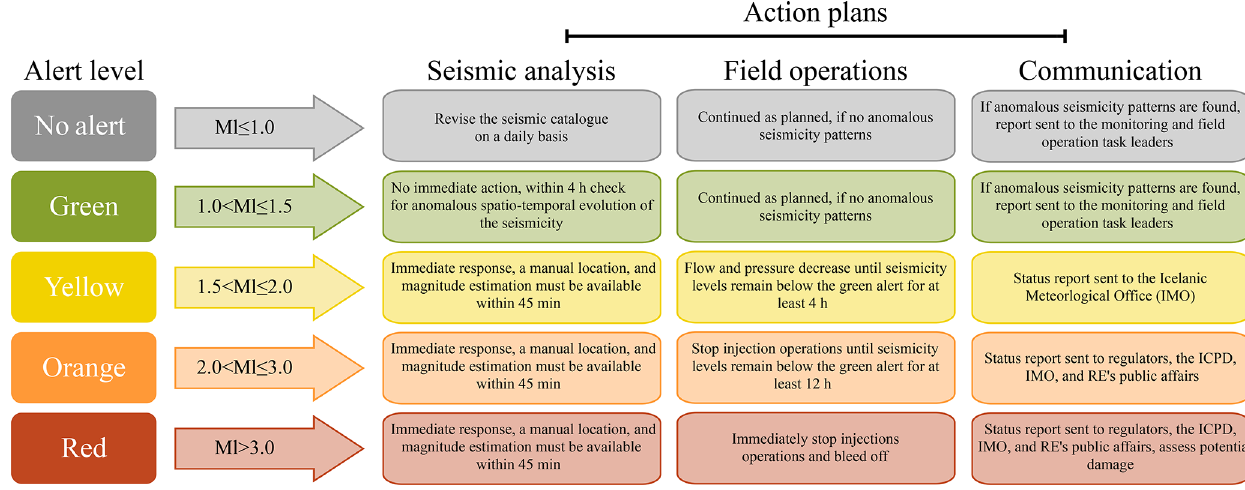
Figure 3. The classic traffic light scheme adopted in the Geldinganes project.